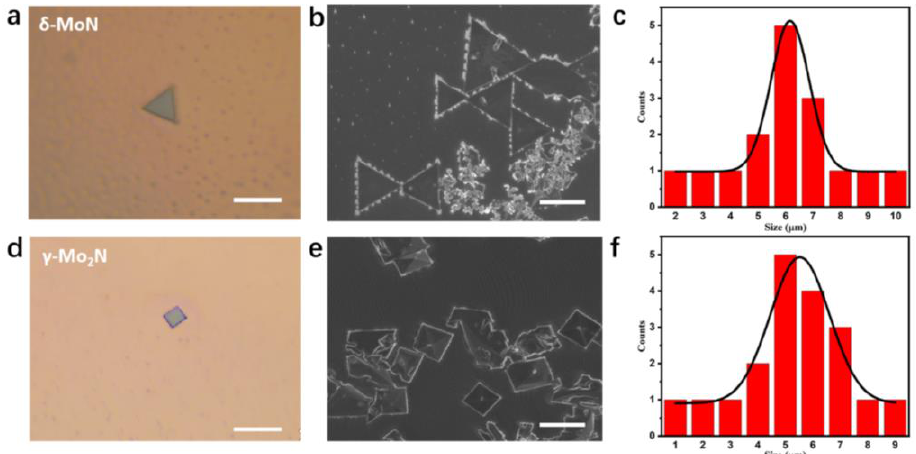
Figure 2. Different crystalline phases of Mo x N y crystals grown on the liquid Cu substrate. ( a ) Optical image of δ -MoN flake. ( b ) SEM of δ -MoN flakes. ( c ) Size statistics of δ -MoN flakes at a region of 40 × 40 μm. ( d,e ) Optical image and SEM of γ -Mo 2 N flakes. ( f ) Size statistics of γ -Mo 2 N flakes at a region of 40 × 40 μm. The sca le bars are 20 μm in ( a ) and ( d ). The scale bars are 5 μm in ( b ) and ( e ).